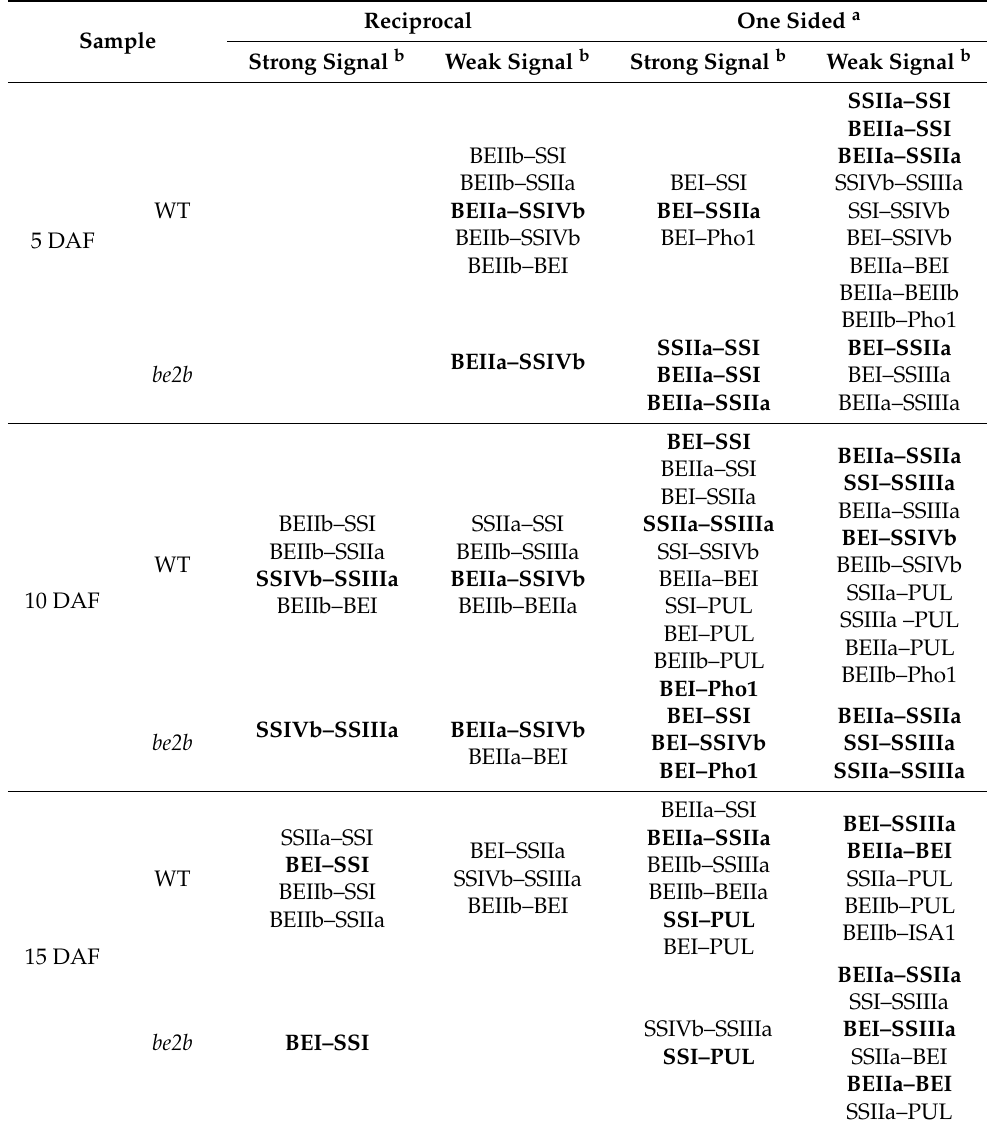
Table 1. Comparison of protein-protein interactions among starch synthetic related enzymes during different grain-filling stages (5 DAF, 10 DAF, 15 DAF) in wild type (WT) and be2b mutant endosperms determined by co-immunoprecipitation. Reciprocal One Sided Sample